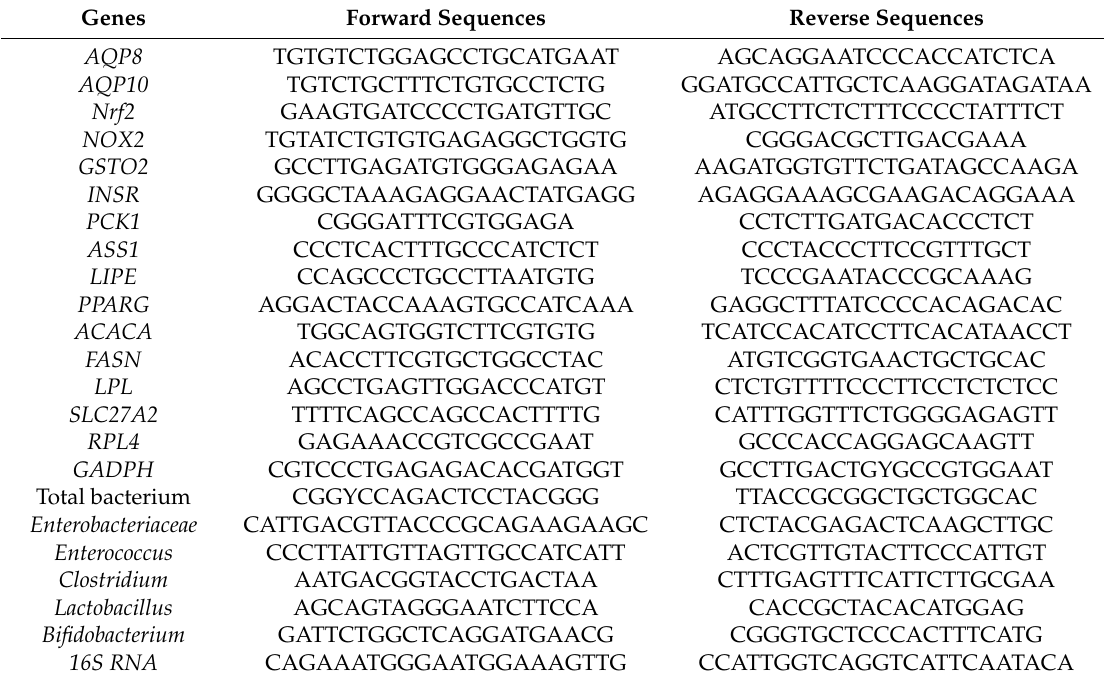
Table 7. Sequences of the primers used for quantitative RT-PCR